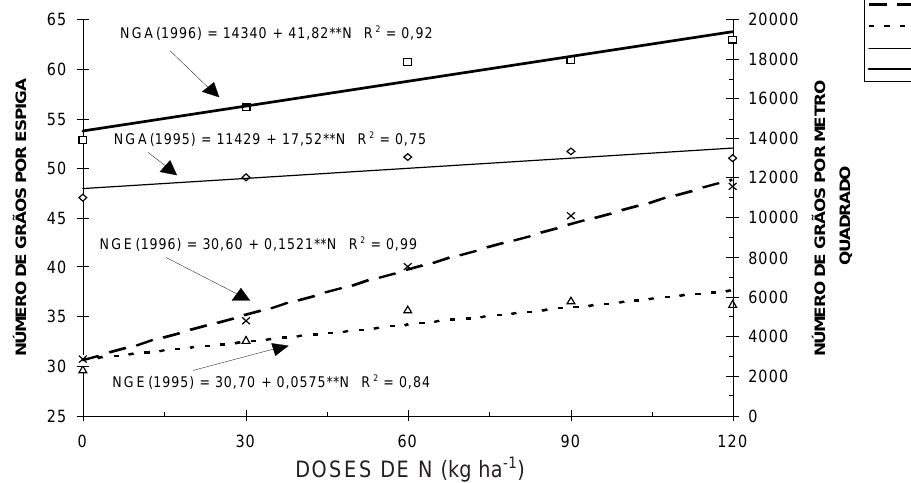
Figura 3. Número de grãos por espiga (NGE) e número de grãos por metro quadrado (NGA) de trigo influenciados pelas doses de nitrogênio (N) em cobertura, em 1995 e 1996.